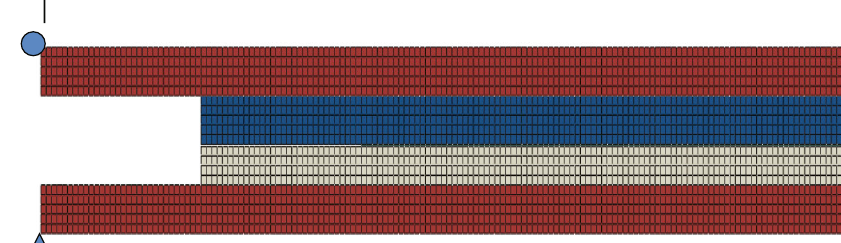
Figure 11: Finite element model and corresponding boundary conditions of the DCSB test.